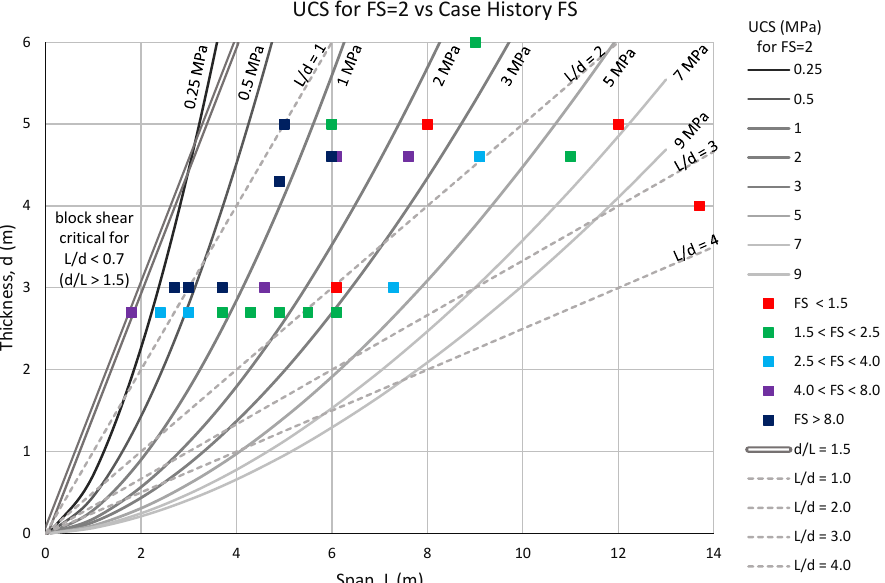
Figure 12. Modified Pakalnis design chart showing actual case history strength factors. (The “block shear critical” criterion for d > 1.5 assumes the mobilized sidewall cohesion is ¼ and ignores frictional resistance that might arise from clamping stress.)